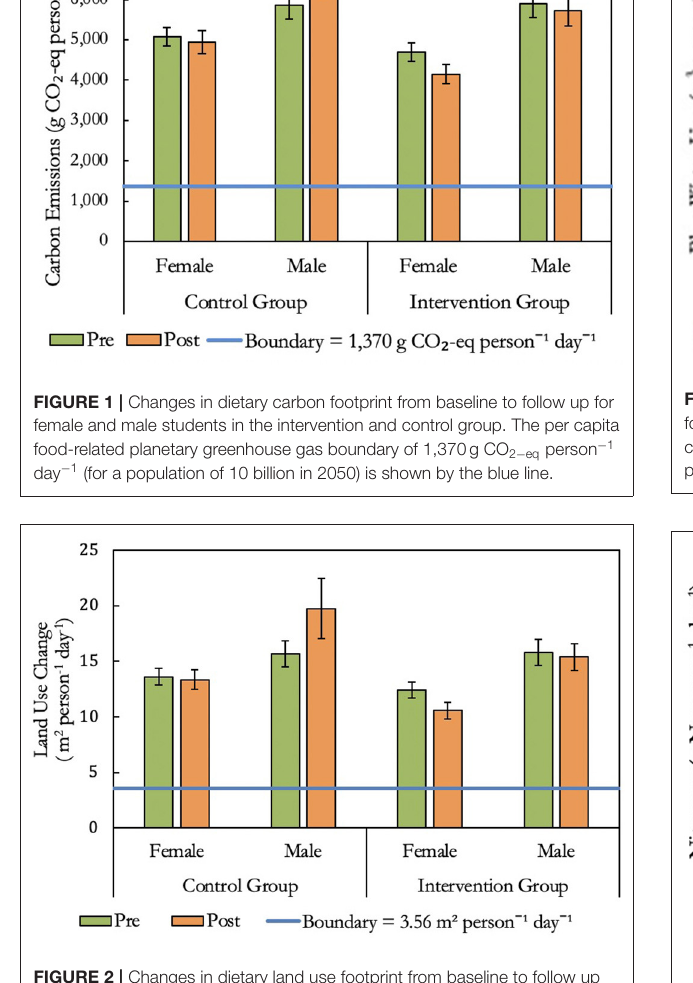
FIGURE 2 | Changes in dietary land use footprint from baseline to follow up for female and male students in the intervention and control group. The per capita food-related planetary boundary of 3.56 m 2 land person − 1 day − 1 (for a population of 10 billion in 2050) is shown by the blue line.